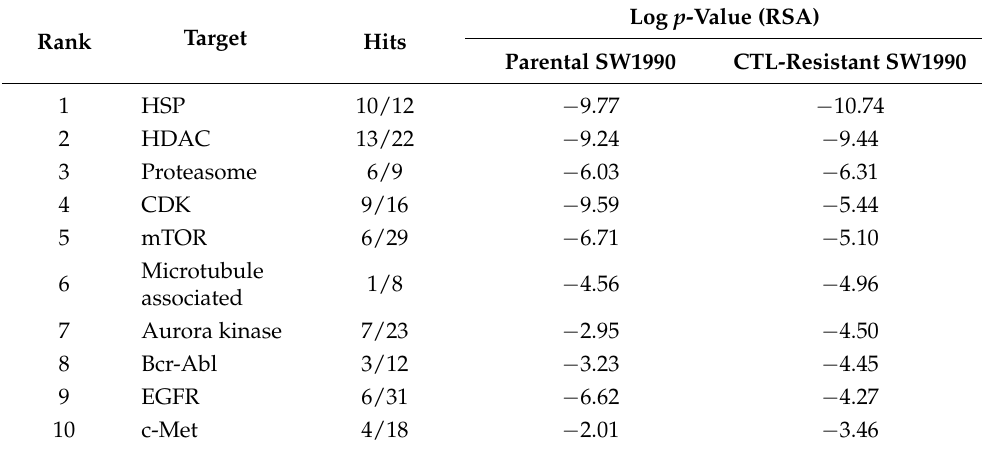
Table 3. Top ten targets of hit compounds identified to inhibit both parental and CTL-resistant PDAC.